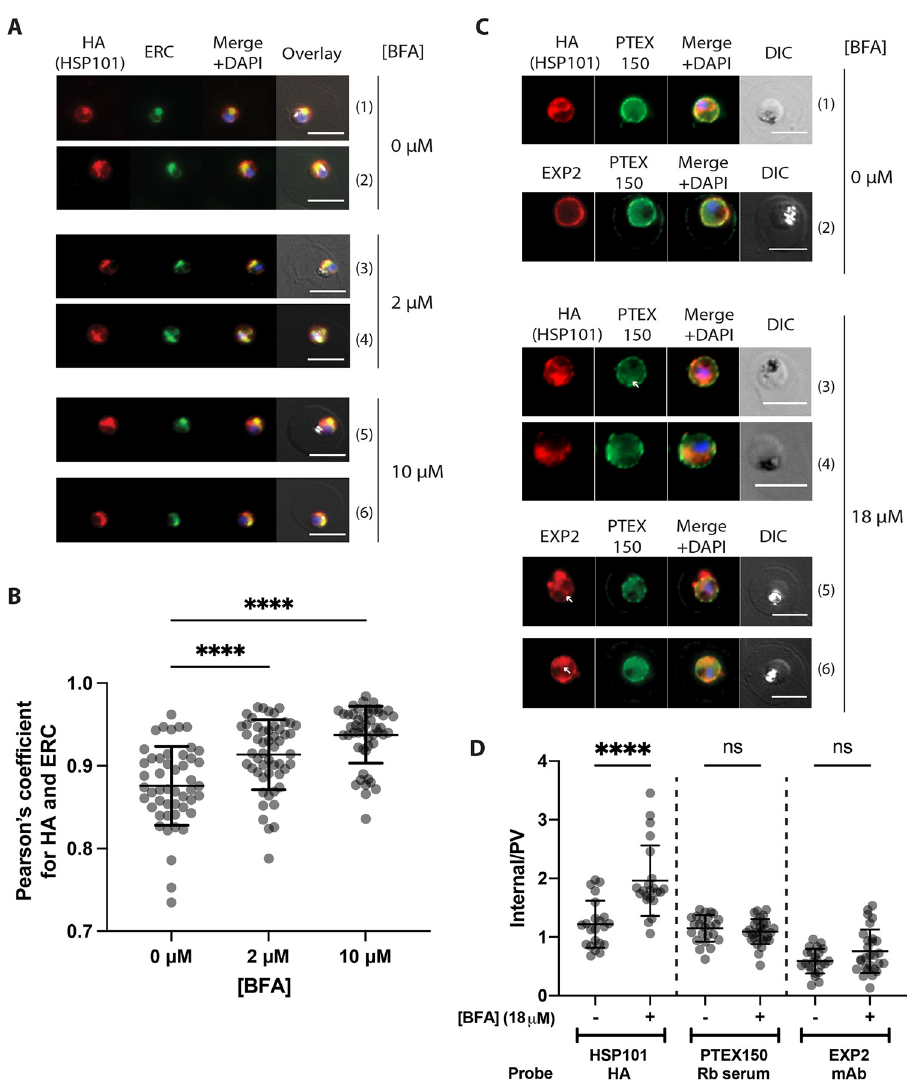
Fig 4. Brefeldin A treatment induces accumulation of HSP101 in the ER. (A) Representative IFA images of HSP101-HA glmS parasites treated with 0, 2, and 10 μ M Brefeldin A (BFA) for 24 hours starting from the ring stage. Cells were fixed and stained with anti-HA (HSP101) and anti-ERC antibodies (ER marker). (B) Quantification of the degree of co-localisation (Pearson’s coefficient) between HA and ERC fluorescence signal indicates that HSP101-HA becomes progressively more trapped within the ER at higher BFA concentrations. The Z-stack images of at least 50 cells were analysed for each treatment. Statistical significances were determined using ordinary one-way ANOVA. ���� , p-value < 0.0001. (C) Older ring stage parasites (16–20 hours post invasion) were treated with 0 and 18 μ M BFA for 5 hours and stained with anti-HA (HSP101) and anti-PTEX150 (rabbit serum; r942) and anti-EXP2 (monoclonal antibody). The images indicate that HSP101 becomes more noticeably trapped within the parasite and depleted from the PV than EXP2 and PTEX150 although there is some accumulation of the latter two proteins within parasite after BFA treatment (white arrow, perinuclear staining of EXP2 and PTEX150). Scale bar, 5 μ m. (D) Quantification of the Internal/PV ratio between the internal parasite and PV signal for the anti-HA, anti-PTEX150, and anti-EXP2 staining with or without 18 μ M BFA treatment. > 20 cells were quantified for each treatment. Statistical significances were determined using an ordinary one-way ANOVA. ���� , p-value < 0.0001. ns, non-significant (p-value > 0.05).